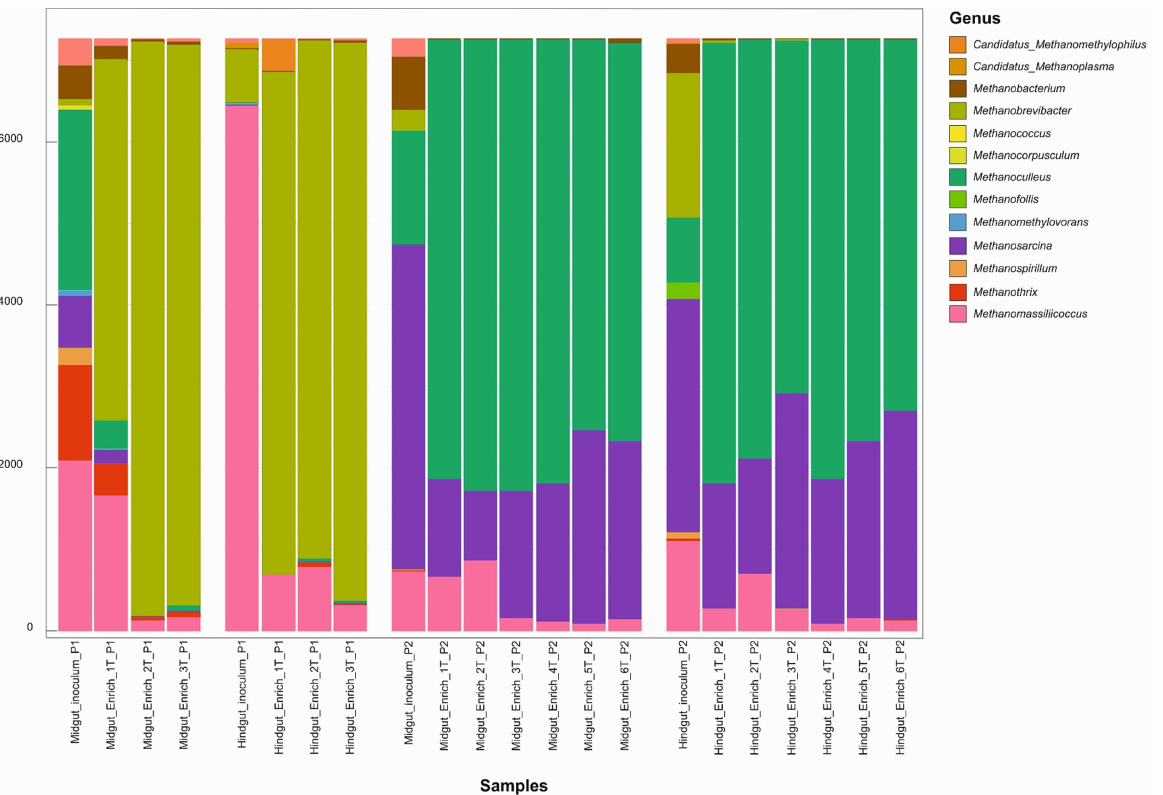
Figure 6. Methanogenic community composition at the genus level analyzed by mcrA gene amplicon sequencing at 30 days of cultivation in midgut and hindgut cultures, over three transfers (P1), over six transfers (P2), and in inocula. NC = not classified at the genus level. The bars show the average of n = 3. Error bars were omitted to improve the figure visibility. The number of sequence reads was rarefied for better